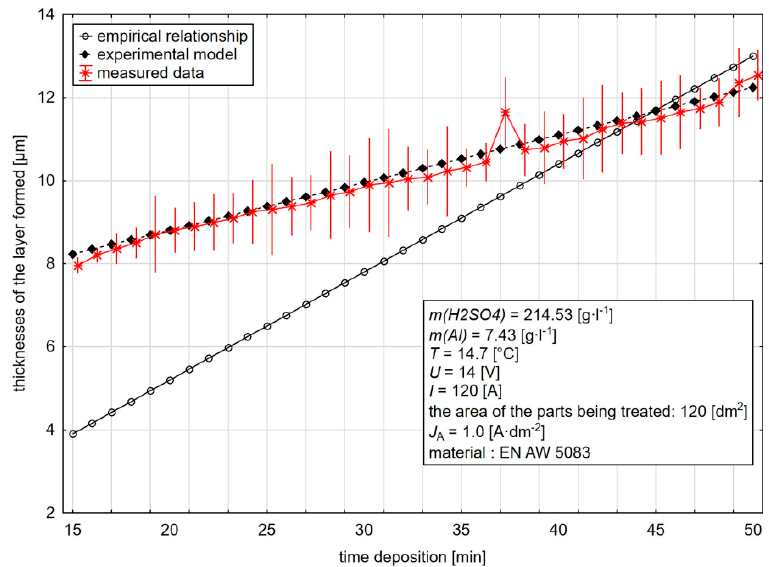
Figure 14. Experimental test diagram as a demonstration for J A \ = \ 1 A · dm − 2 (at values: m (H 2 SO 4 ) = 214.53 g · L − 1 , m (Al) = 7.43 g · L − 1 , T = 14.7 ◦ C, U = 14 V, I = 120 A, surface area of the treated parts 120 dm 2 , material EN AW 5083) of the anodic oxidation process in practical verification.